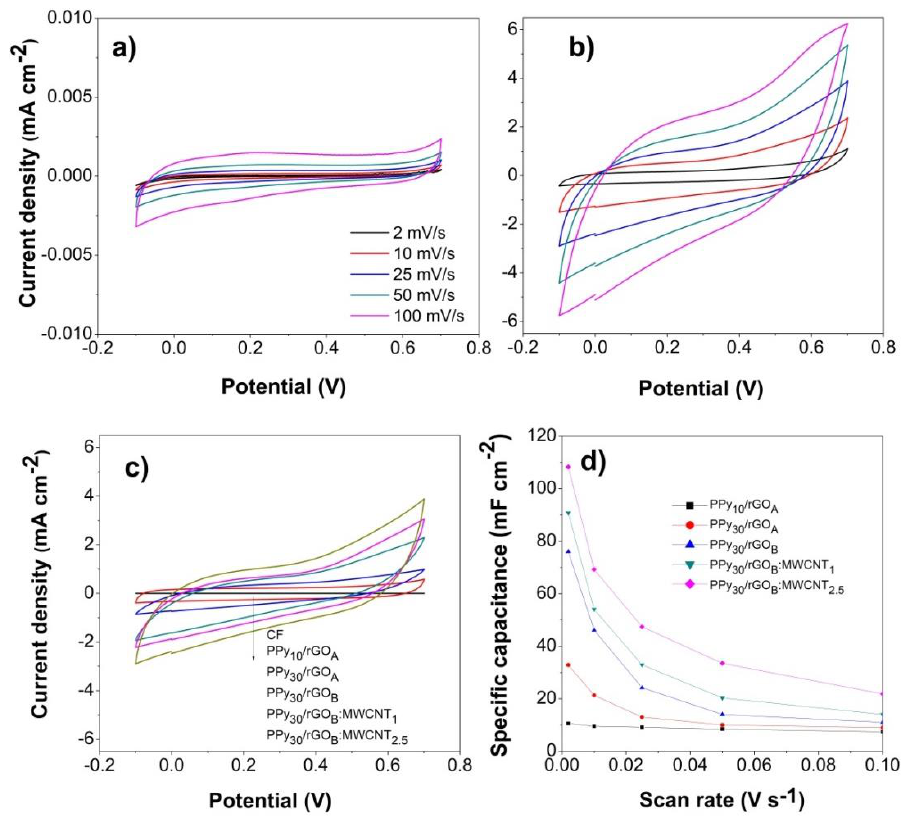
Figure 5. Cyclic voltammograms (CV) (V vs. Ag/AgCl) for CF substrate ( a ) and PPy 30 / rGO (B) :CNT 2.5 -modified one ( b ) with the scan rate ( c ); CV comparison for the modified substrates at 5 mV s − 1 and ( d ) areal capacitance as a function of scan rate.